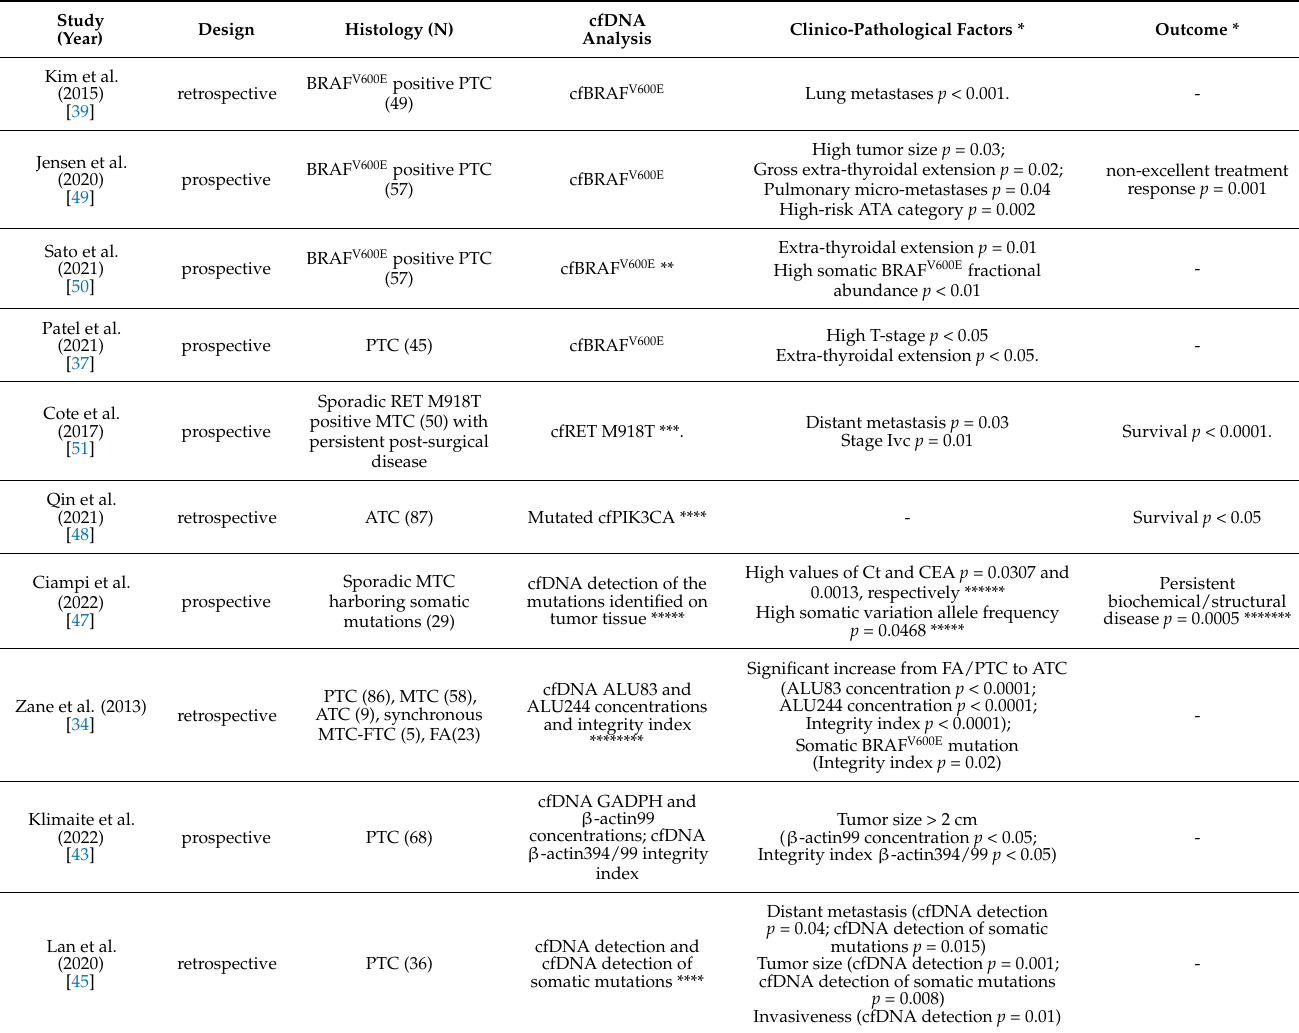
Table 3. Characteristics and findings of studies assessing the prognostic value of cfDNA in thyroid